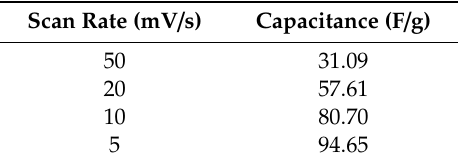
Table 4. C spe value of the PVCSG3 film at the various scan rates of 50, 20, 10, and 5 mV / s.